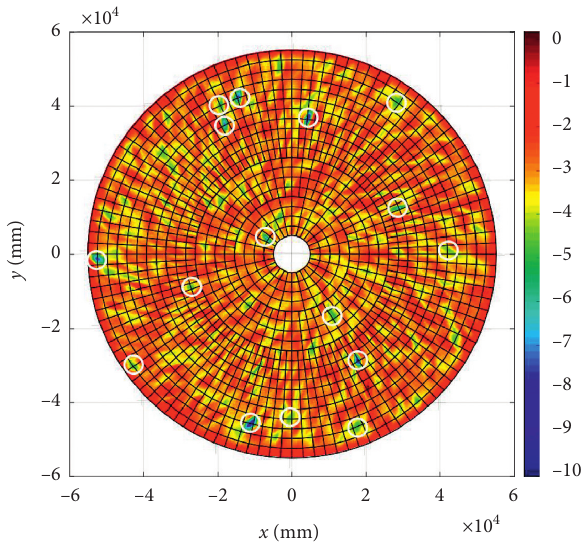
Figure 4: Main reflector in case of actuator failure.